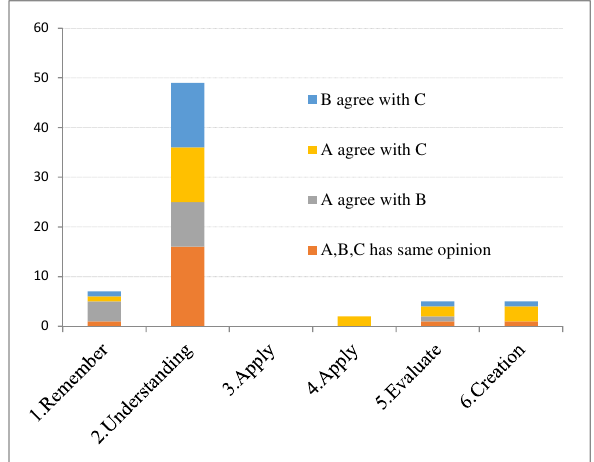
Figure 1. Bar chart of students’ cognitive development